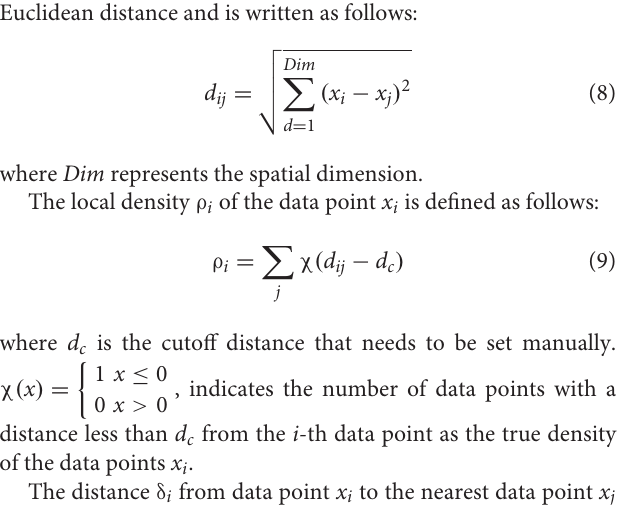
point x j is greater than that local density of data point x i and the distance is the